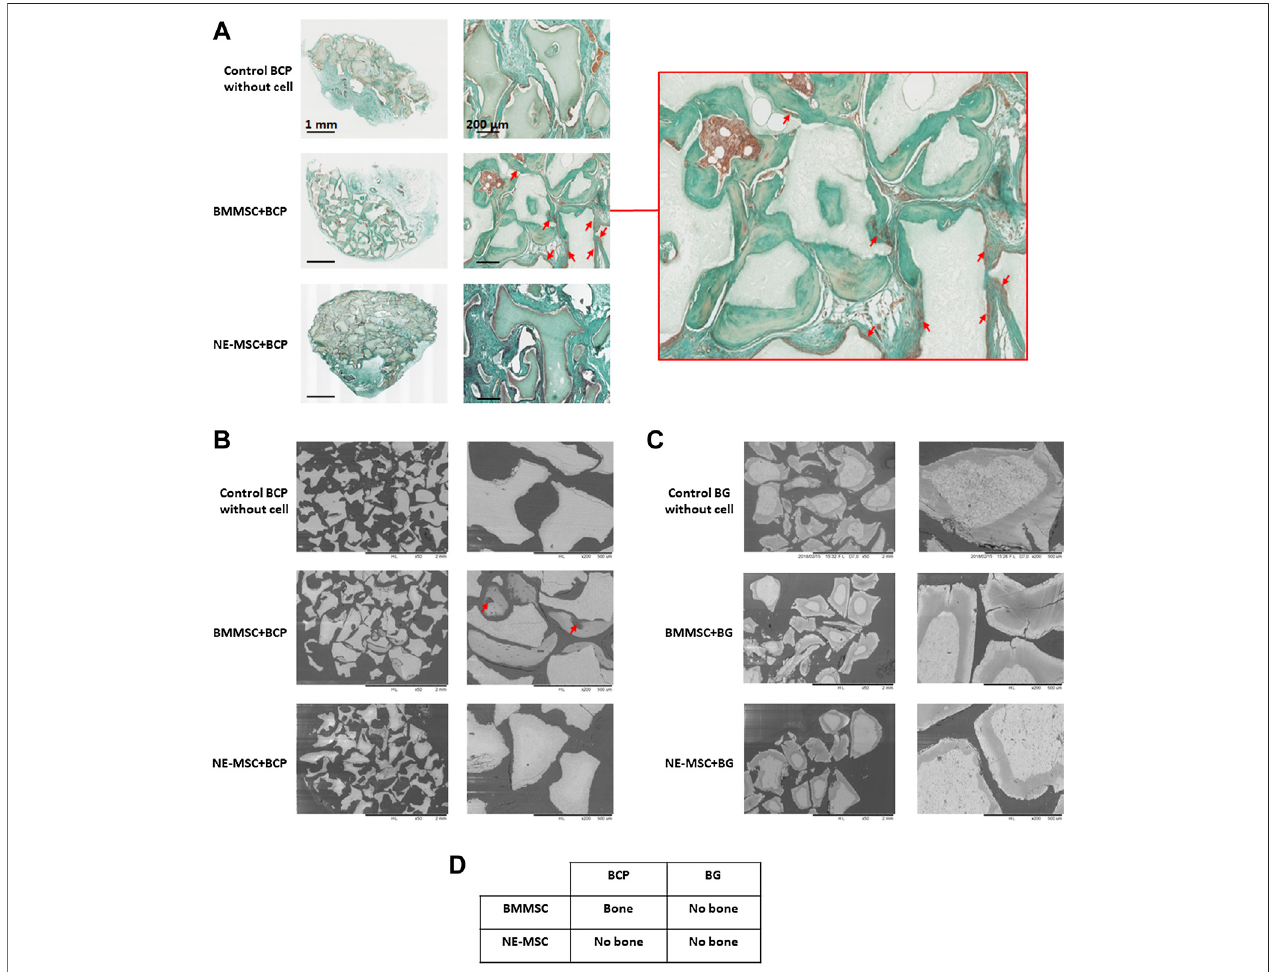
FIGURE 9 | In vivo bone formation, 8 weeks after subcutaneous implantation in nude mice. (A) BMMSCs give rise to osteoblasts, stained with Masson trichrome (red arrows), but not NE-MSCs and cell-free BCP biomaterial. (B) The same fi nding is observed when the implants are analyzed with an electronic microscope (red arrows). (C) No bone formation is observed when cells were loaded in BG biomaterial. (D) Table summarizing the fi